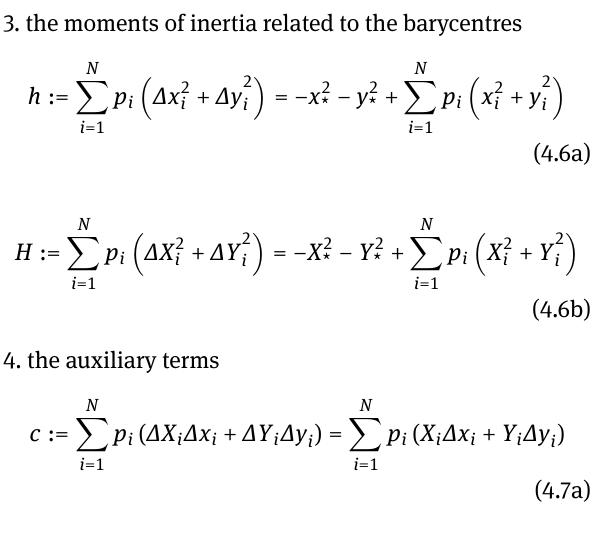
with transformation parameters X lated equations can be formulated for the opposite trans- formation